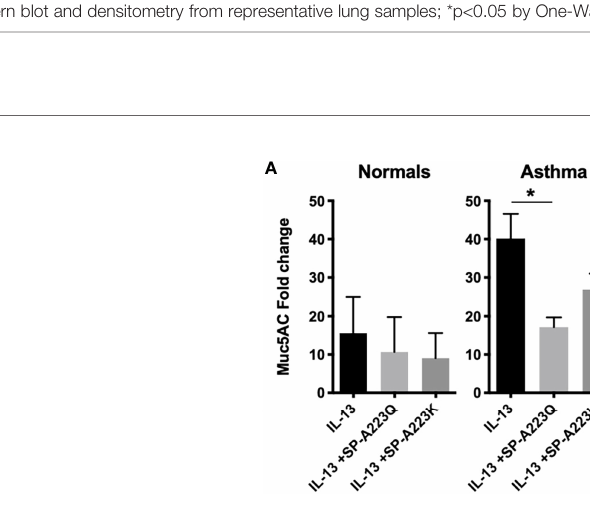
FIGURE 1 | Genetic variation in SP-A2 determines extent of protection against IL-13 induced in fl ammation in humanized SP-A transgenic mice. BAL cells from (A) IL-13 challenged mice, which consisted of and (B) macrophages, (C) neutrophils and (D) eosinophils. (E) PAS scored lung histology from IL-13 challenged mice. N=12 WT; 15 SP-A -/- ; 8 SP-A223Q/Q; 12 SP-A223K/K per group from 3 separate experimental repeats. *p < 0.05, **p < 0.01, ***p < 0.001. ****p < 0.0001 by One-way Anova with Dunnett ’ s test for multiple comparisons. (F) Representative PAS images of each genotype treated with IL-13. (G, H) Stat3 phosphorylation by Western blot and densitometry from representative lung samples; *p<0.05 by One-Way Anova with Tukey ’ s multiple comparisons.